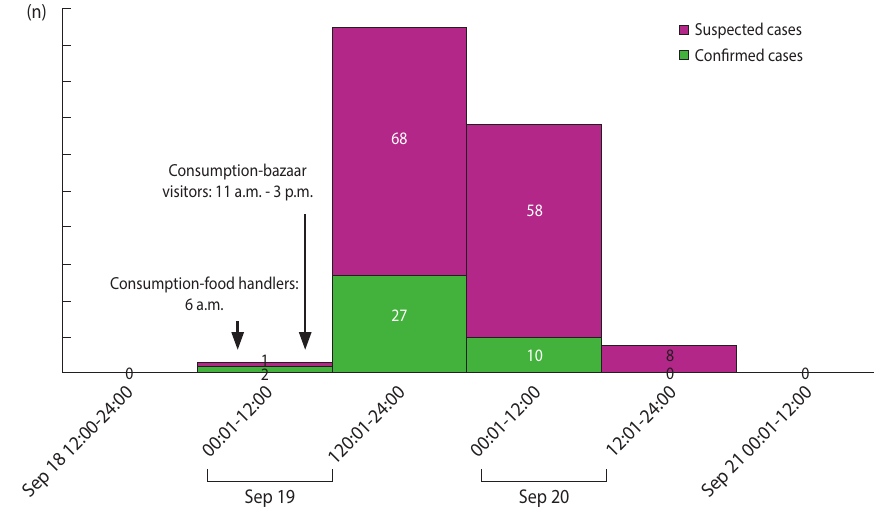
Figure 1. Epidemic curve about outbreak of enterocolitis caused by Vibrio Table 1. Attack rates and RRs of gastroenteritis among 174 persons having meals 1 Exposed Non-exposed Meal Total Attack rate (%)